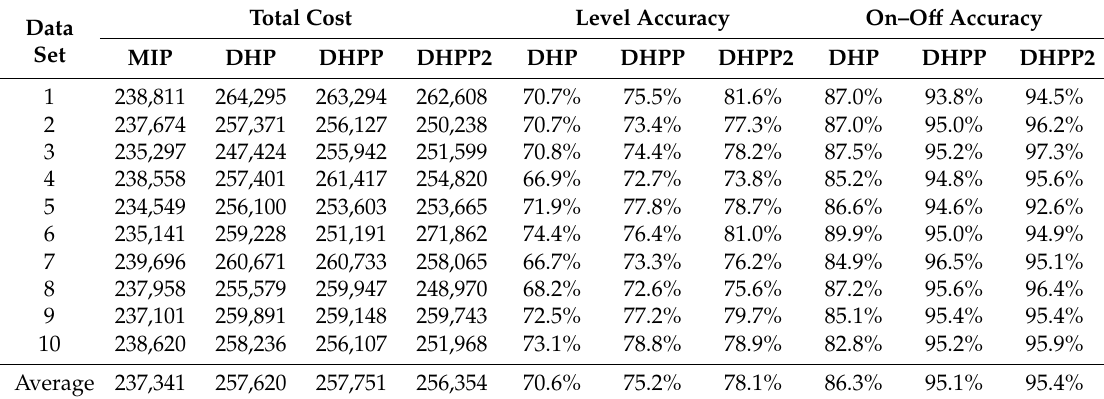
Table 5. Comparison of Cost and Accuracy Measures by Models.